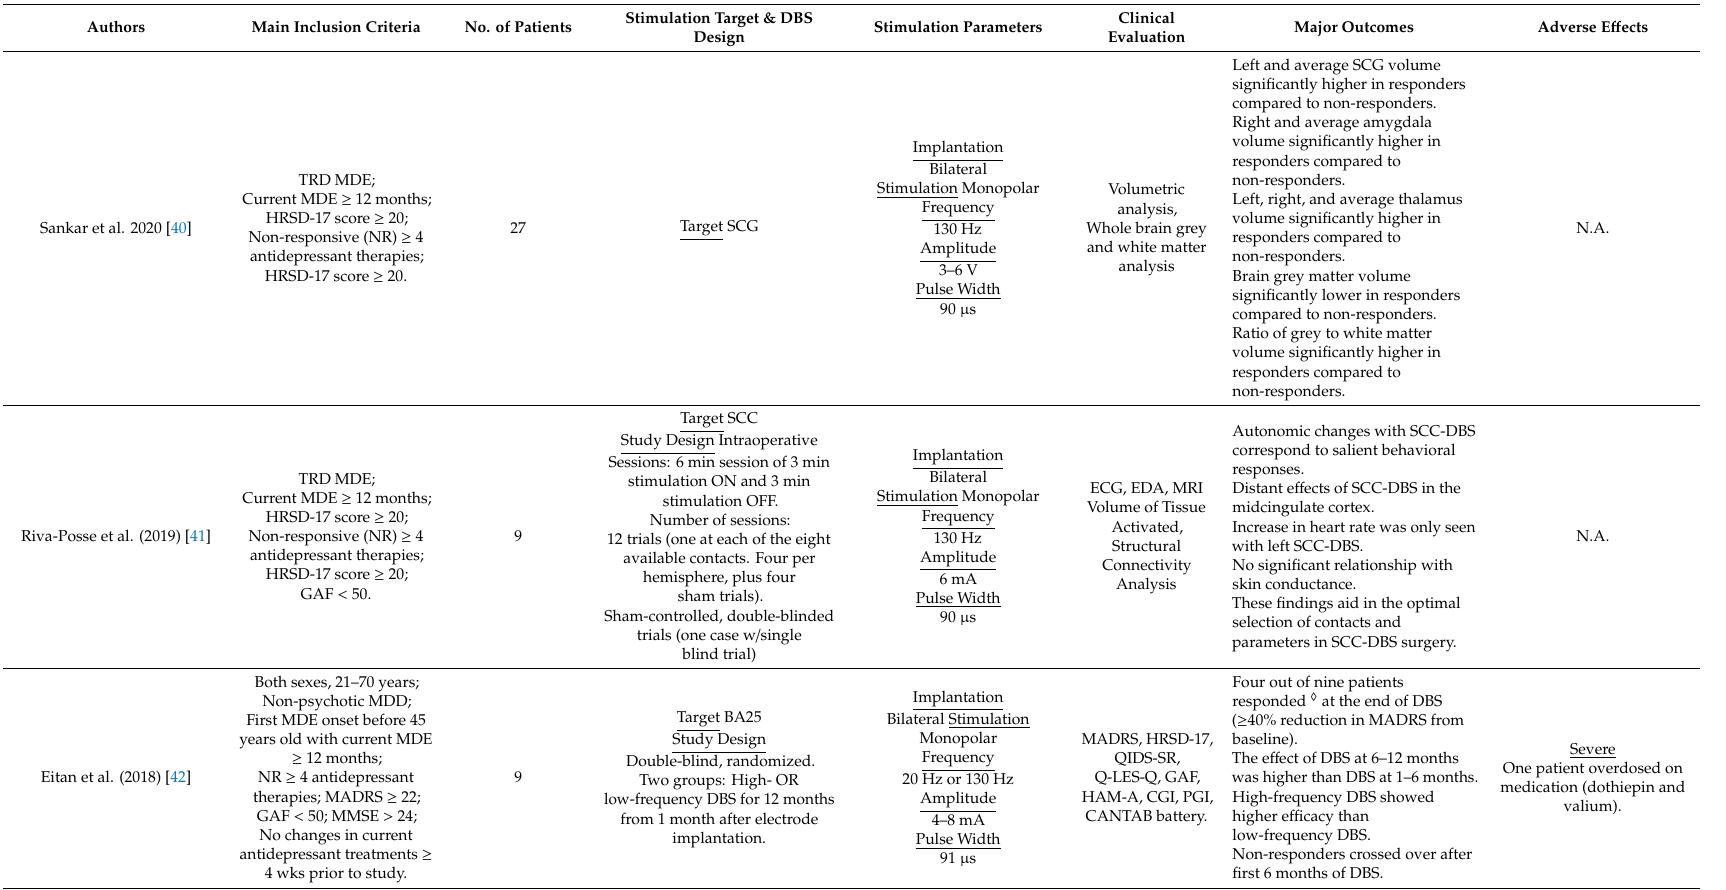
Table 1. A list of clinical studies on deep brain stimulation of the human subcallosal